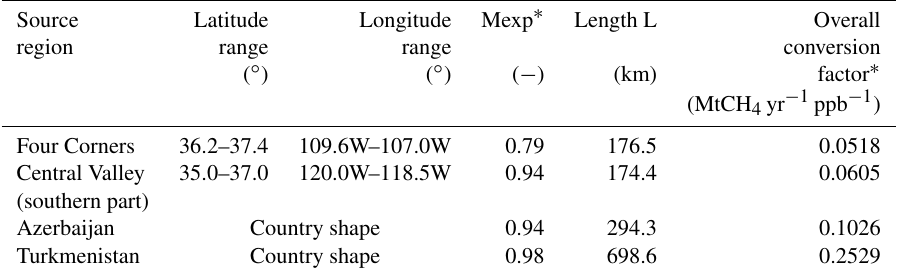
Table 2. Details related to the four source regions and their parameters as used for the emission estimation. Source